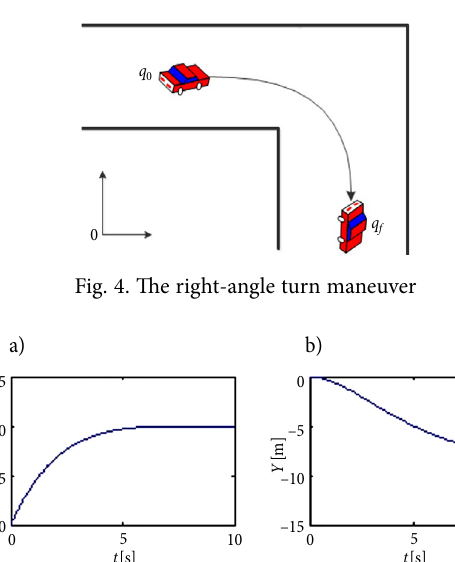
Fig. 2. The lane change maneuver